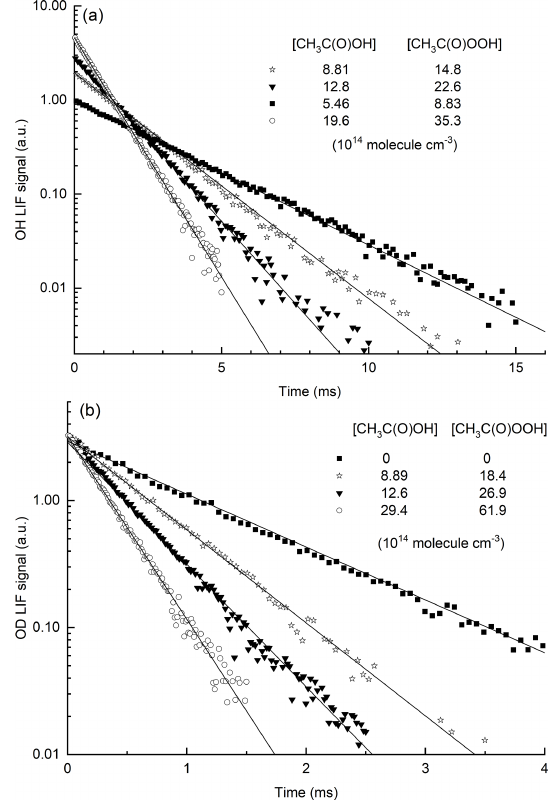
Figure 5. (a) Exponential decay of the OH LIF signal in the presence of CH 3 C(O)OOH and CH 3 C(O)OH in ≈ 150TorrN 2 at 353K. OH was generated by the photolysis of CH 3 C(O)OOH at 248nm. (b) Exponential decay of the OD LIF signal in the pres- ence of CH 3 C(O)OOH and CH 3 C(O)OH in N 2 at 298K. OD was generated from the 248nm photolysis of DONO 2 .